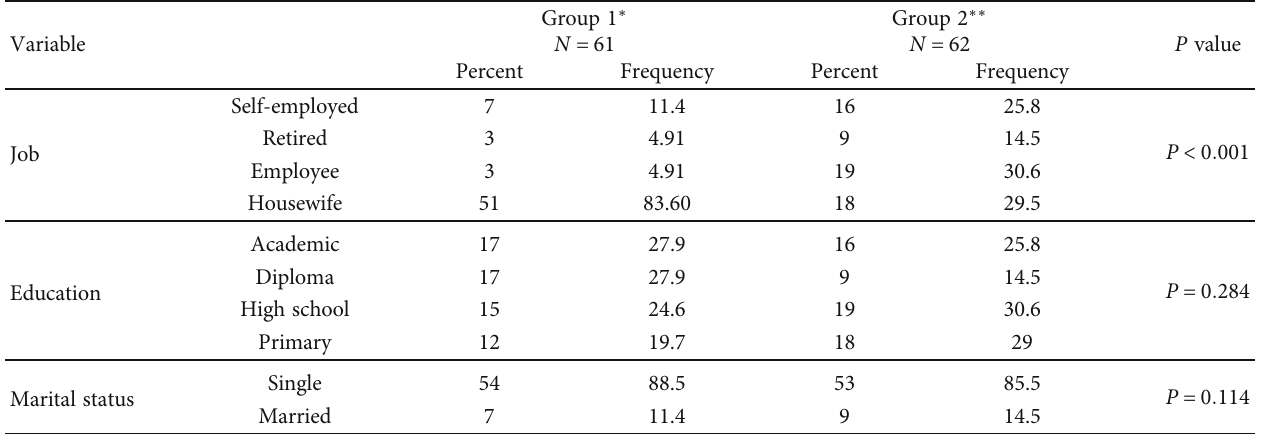
Table 1: Demographic characteristics of patients in the intervention and control groups.